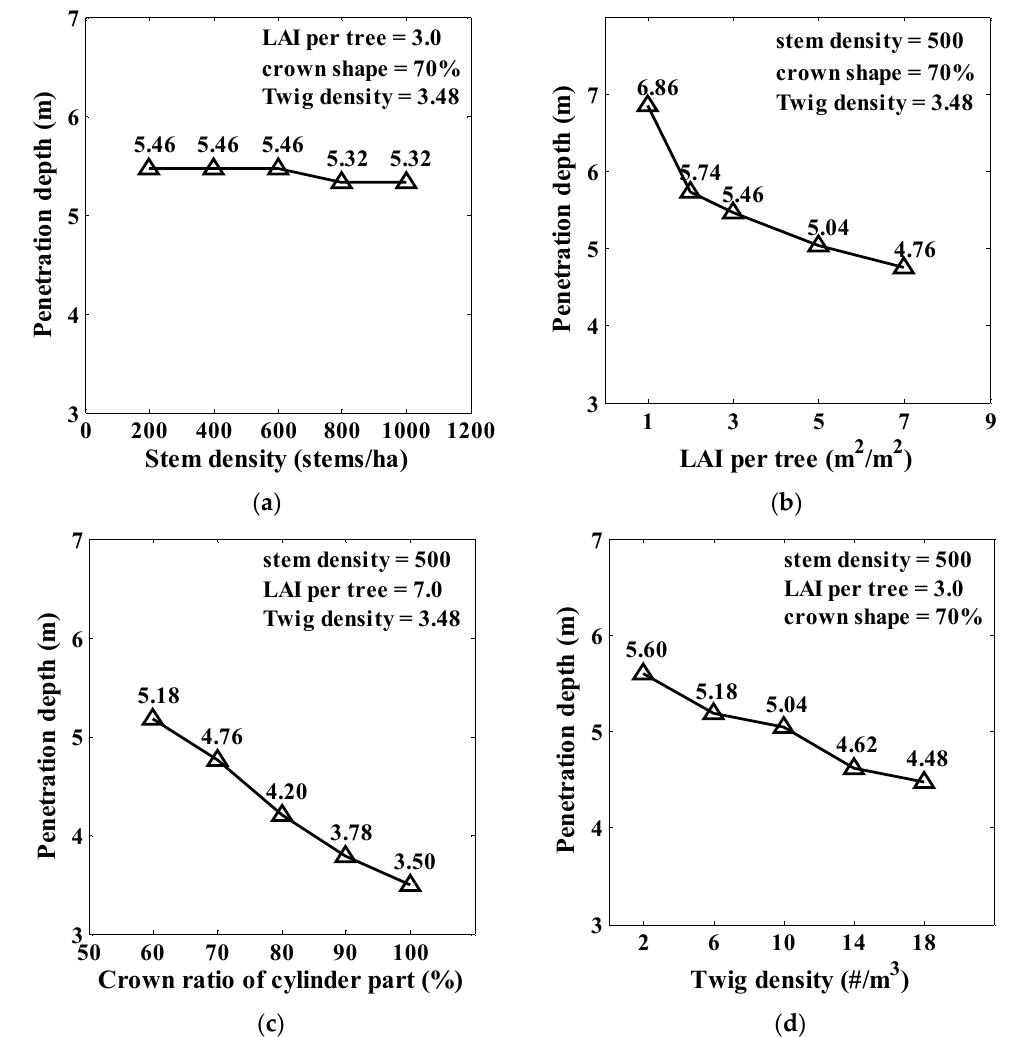
Figure 11. The penetration depth variations due to the forest scenes vary with ( a ) stem density when single tree LAI was 3.0, crown ratio of cylinder part was 70%, and twig density was 3.48; ( b ) single tree LAI when stem density was 500 stems/ha, crown ratio of cylinder part was 70%, and twig density was 3.48; ( c ) crown ratio of cylinder part when stem density was 500 stems/ha, single tree LAI was 7.0, and twig density was 3.48; ( d ) twig density when stem density was 500 stems/ha, single tree LAI was 3.0, and crown ratio of cylinder part was 70%.